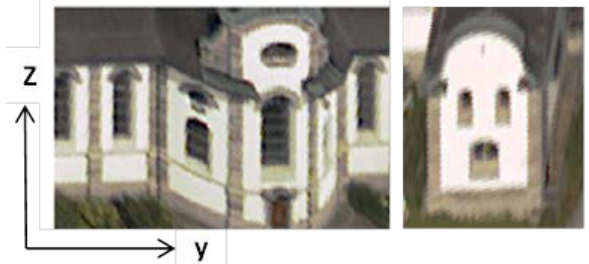
Figure 6. Façade plots with photo texture derived from oblique aerial images taken from East and North of the church. A pixel size at the façade of 10cm was selected.